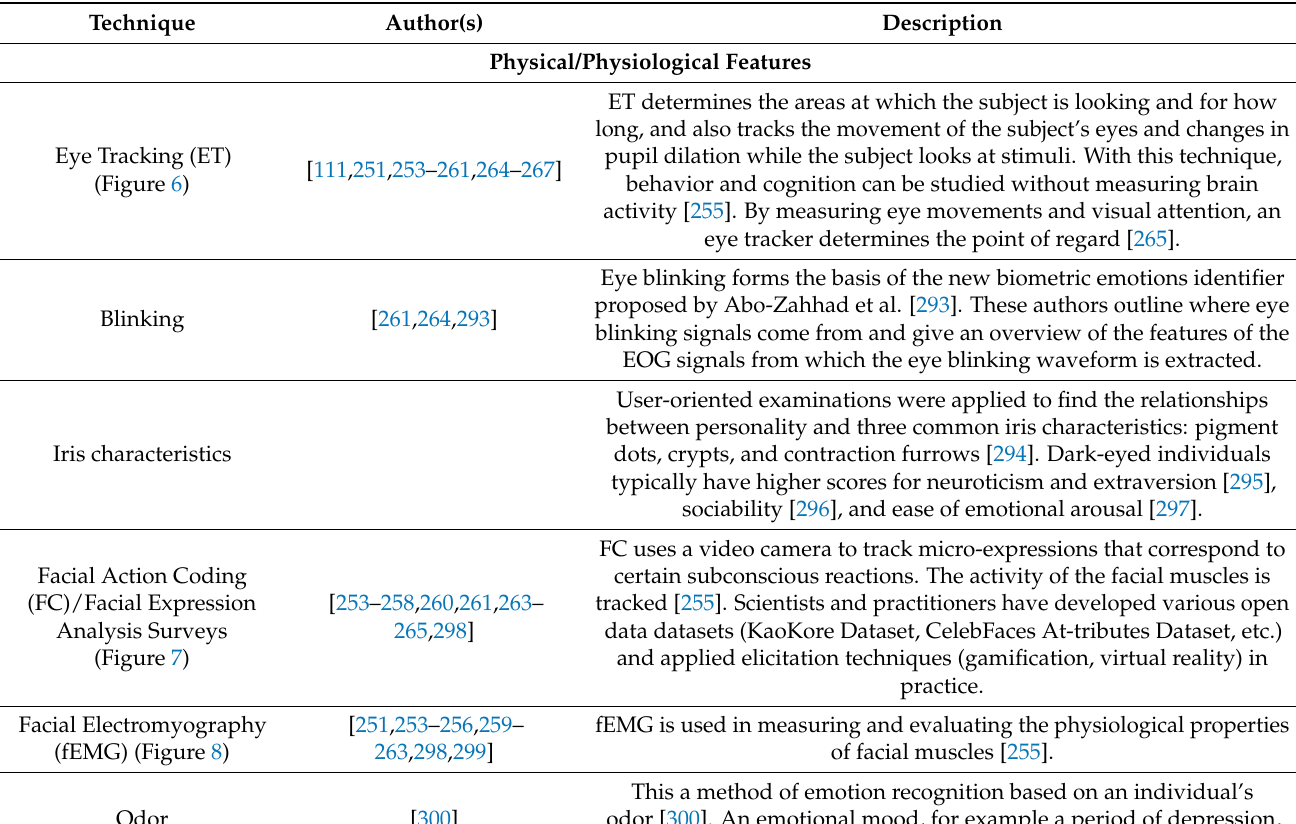
Table 2. Physiological and behavioral